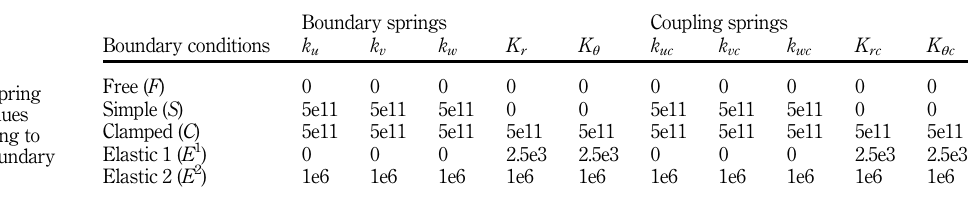
Table 2. Boundary spring stiffness values corresponding to different boundary